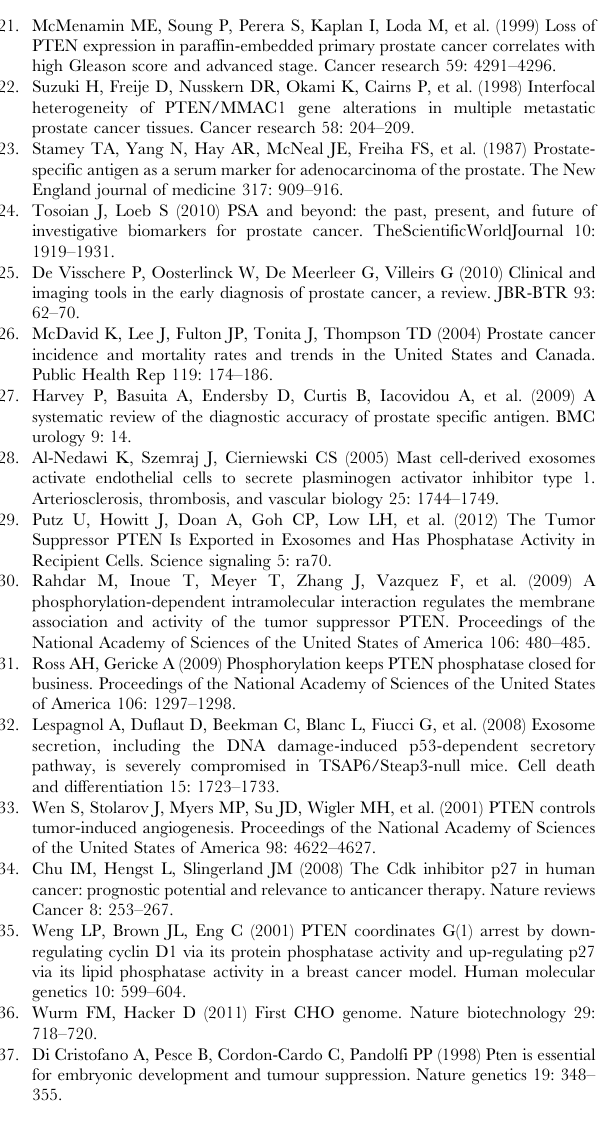
Figure S2 Different cancer cell types express PTEN in their exosomes, and transfer PTEN to other